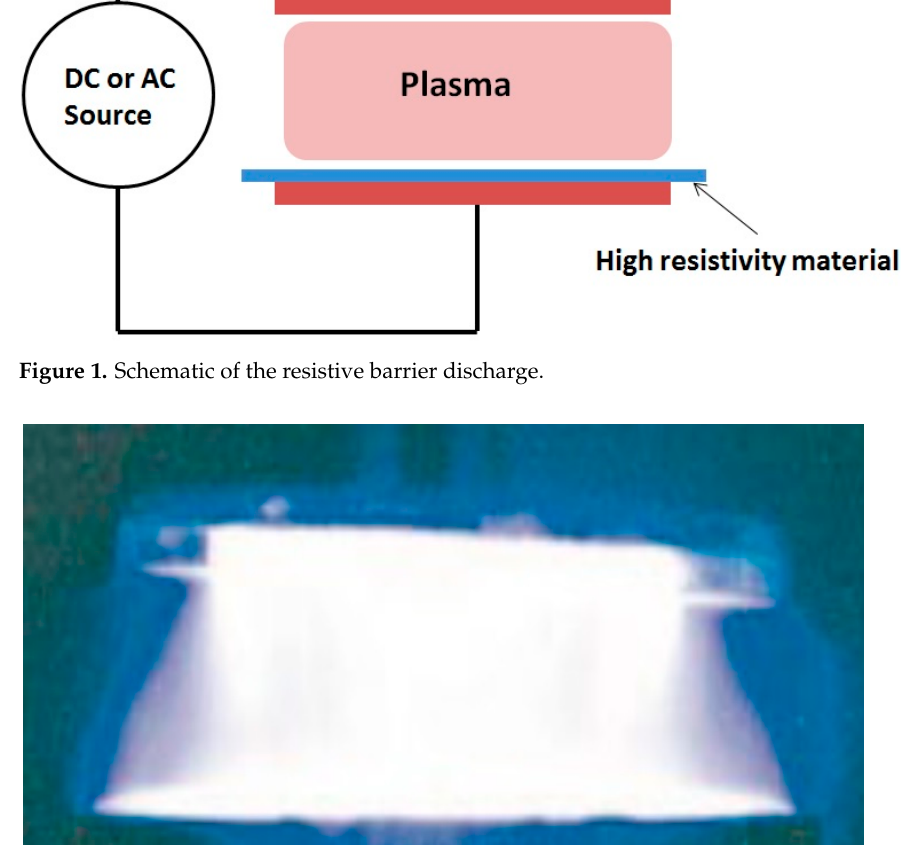
Figure 2. Photograph of the plasma generated by a resistive barrier discharge (RBD) in helium. The gap distance between the electrodes is 4.5 cm, and the voltage is 13 kV RMS at 60 Hz [22]. The input power is around 100 W.